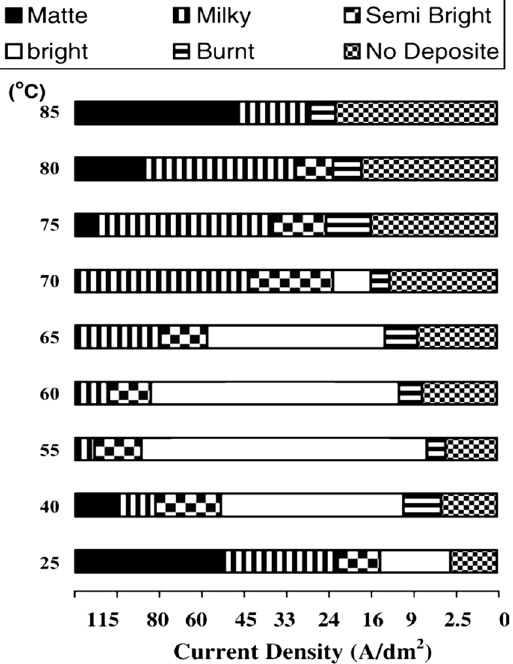
Figure 3. Effects of temperature and current density on the appearance of chromium electrodeposits. Reprinted with permission from [69]. Copyright 2003 Elsevier.